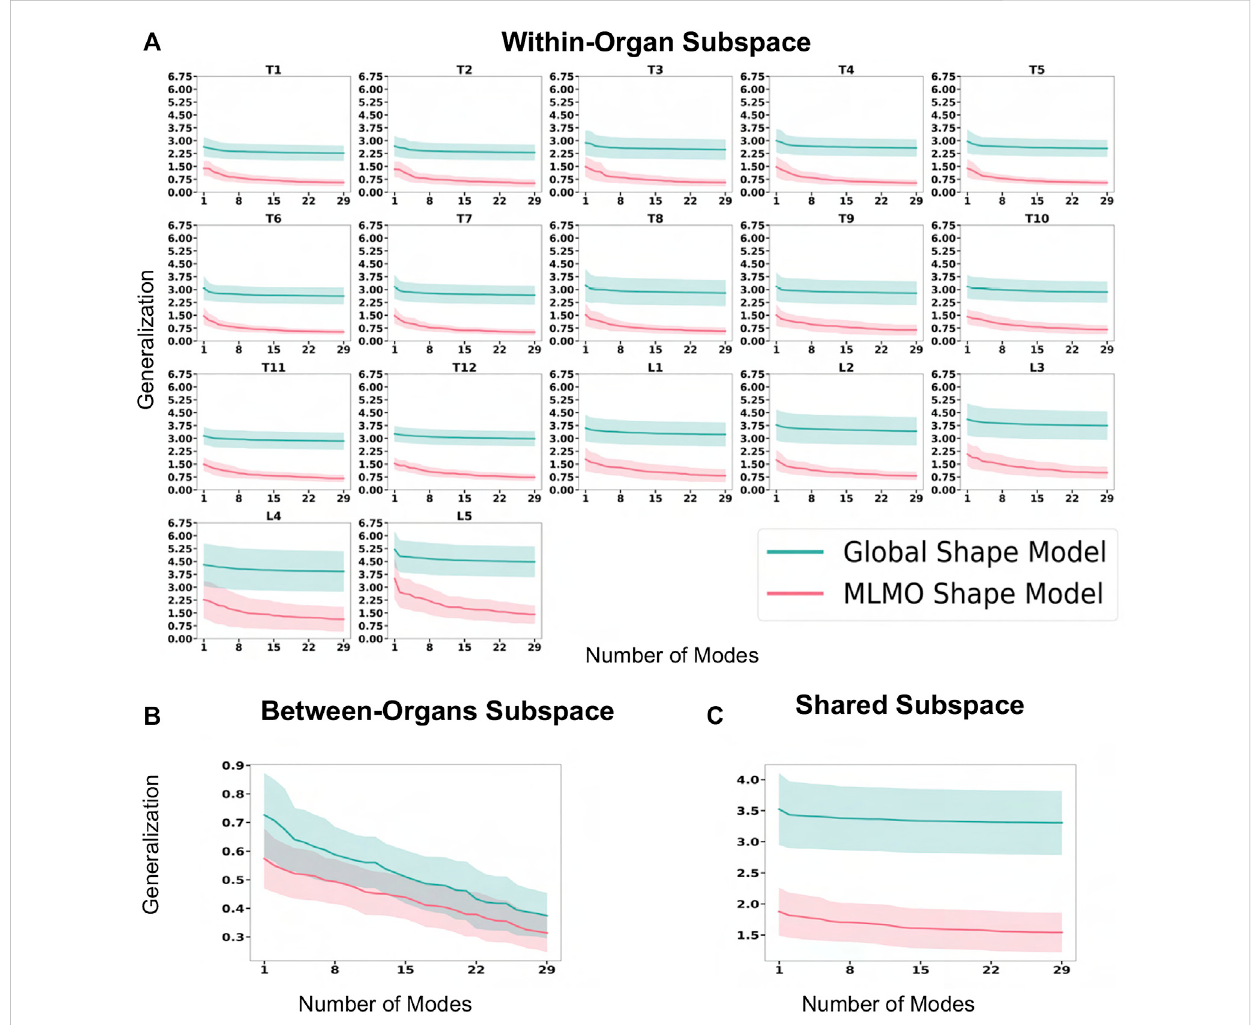
FIGURE 6 Generalization error (in mm ) for spinal column data — (A) within-organ subspace. (B) Between-organs subspace. (C) Shared